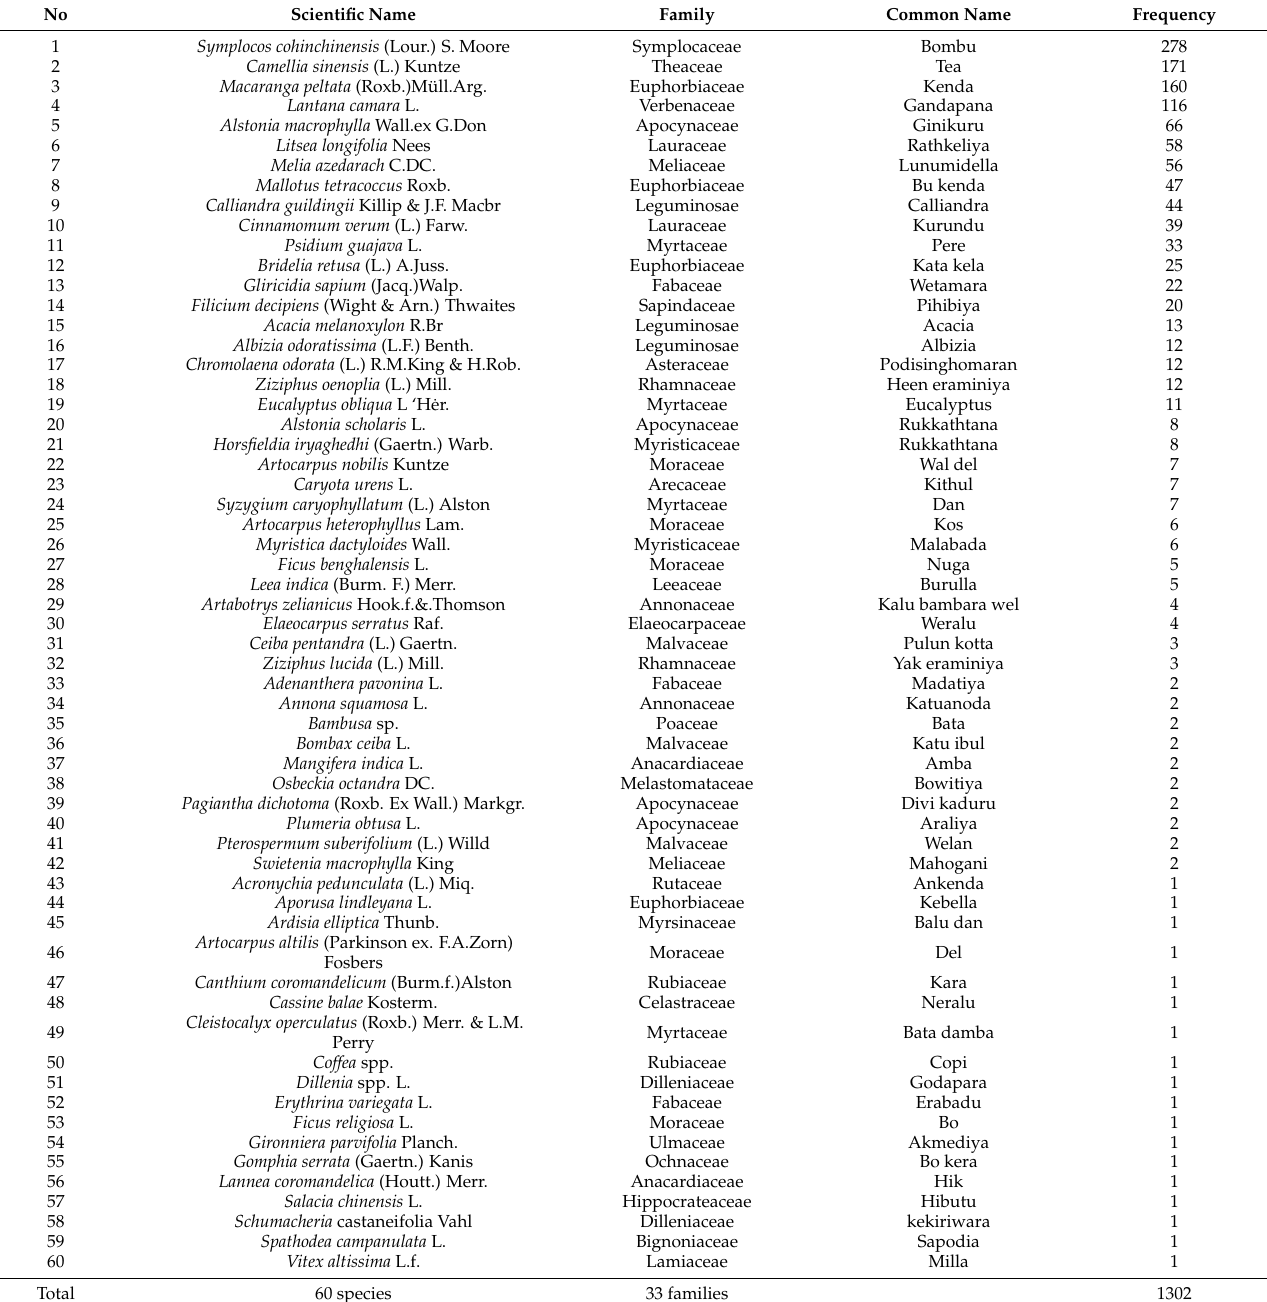
Table A1. List of woody species recorded in the Endane Biodiversity Corridor, linking the Iharakanda Proposed Forest Reserve and Sinharaja Forest Complex in the Rathnapura District of Sri